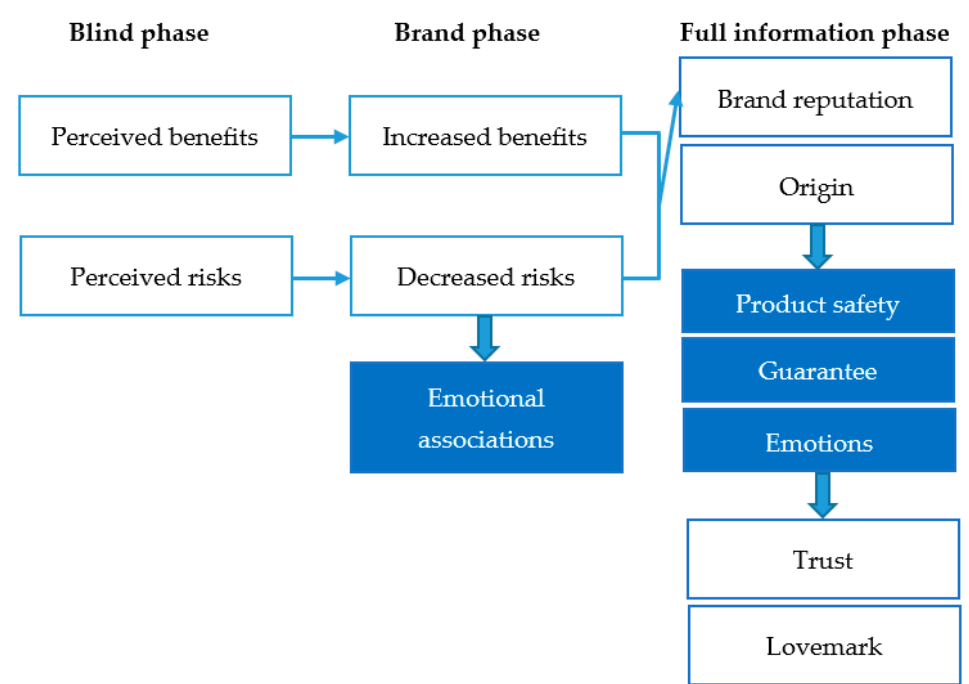
Figure 2. The role of brand reputation and design in consumer preferences regarding mineral water consumer decision.